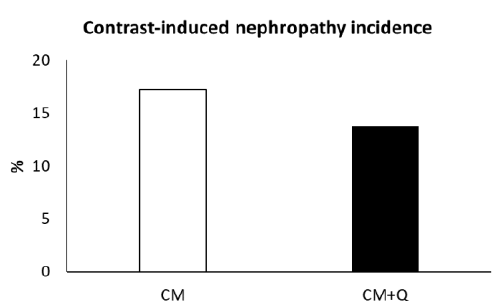
Figure 1. Contrast-induced nephropathy (CIN) incidence, calculated as % of patients whose increase in